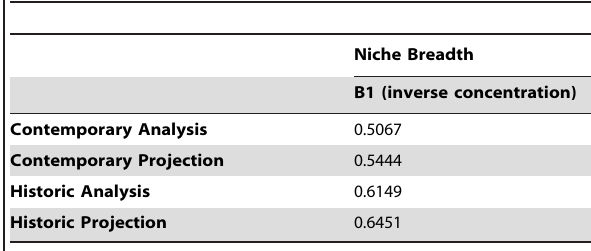
Table 3. The Levin’s Niche breadth analysis outputs a scale of specialization between 0 and 1, where ‘‘0’’ is a specialist and ‘‘1’’ is a